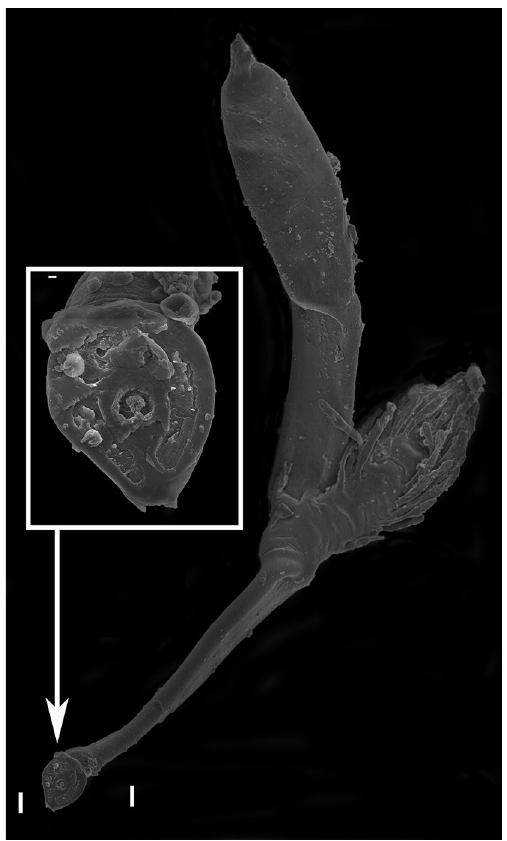
Figure 2. Rickia gigas on the cuticle of the millipede Tropostreptus hamatus, SEM image, thallus and detail of the inner part of the foot. Scale bars: 10 μm in overview, 1 μm in detail image.